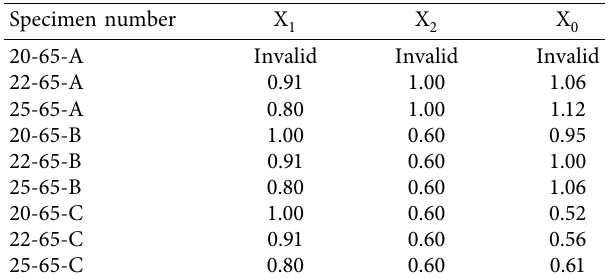
Table 5: Comparison sequence with reference sequence